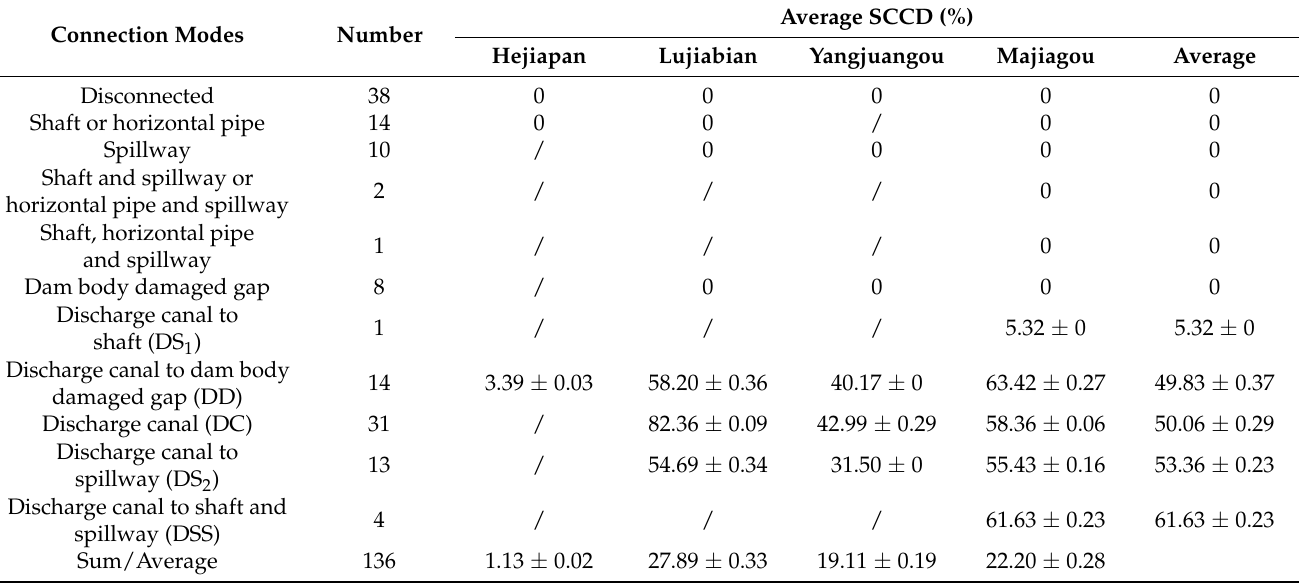
Table 2. Average SCCD of different connection modes in the four